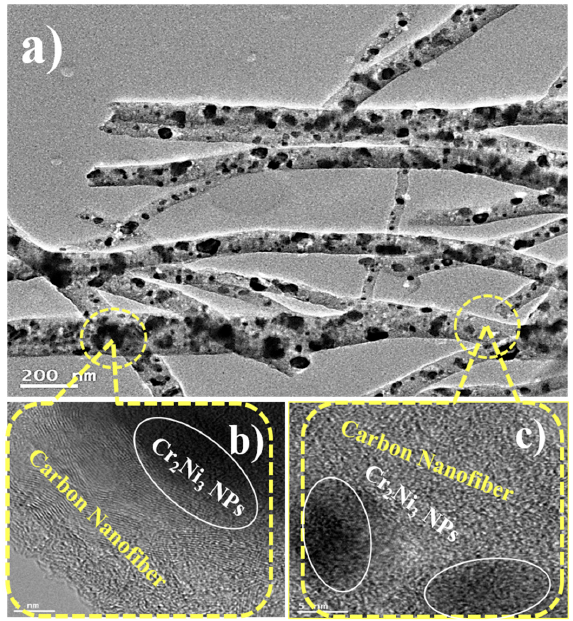
Figure 3. Normal TEM ( a ), and HRTEM images ( b , c ) of the as-synthesized Cr 2 Ni 3 NPs@CNFs.